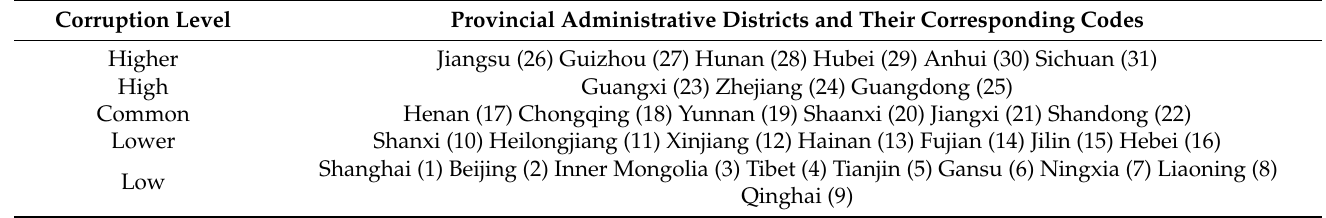
Table 1. Provincial corruption level classification table.